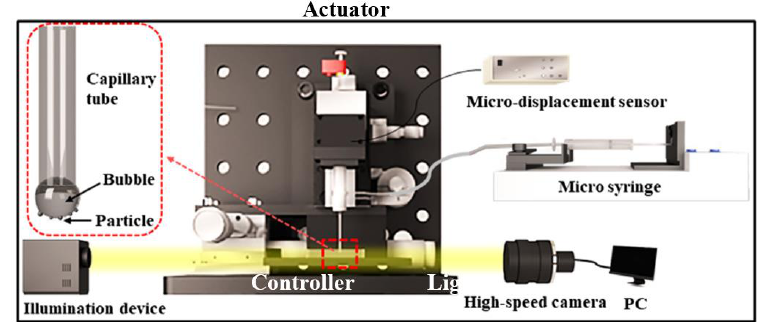
Figure 1. The induction time measuring system [22, Reproduced with permission from Xia Y., Fuel; published by Elsevier, 2019].